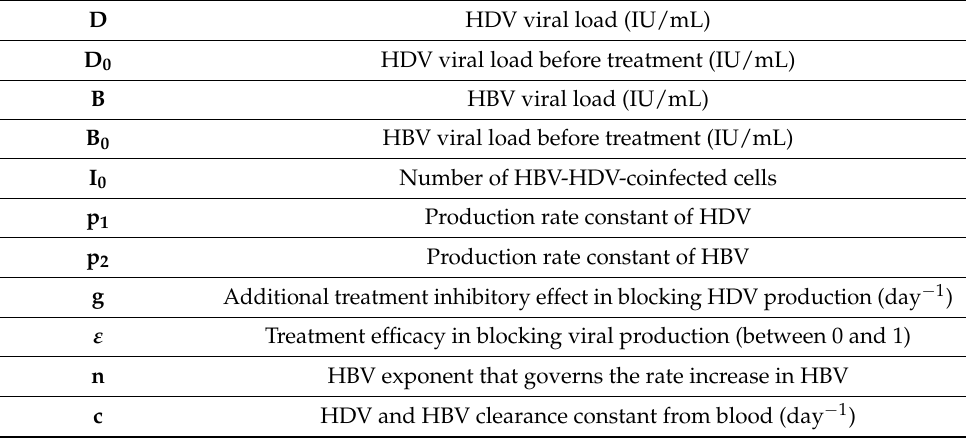
Table 3. The variables and the parameters of our new model (along with their